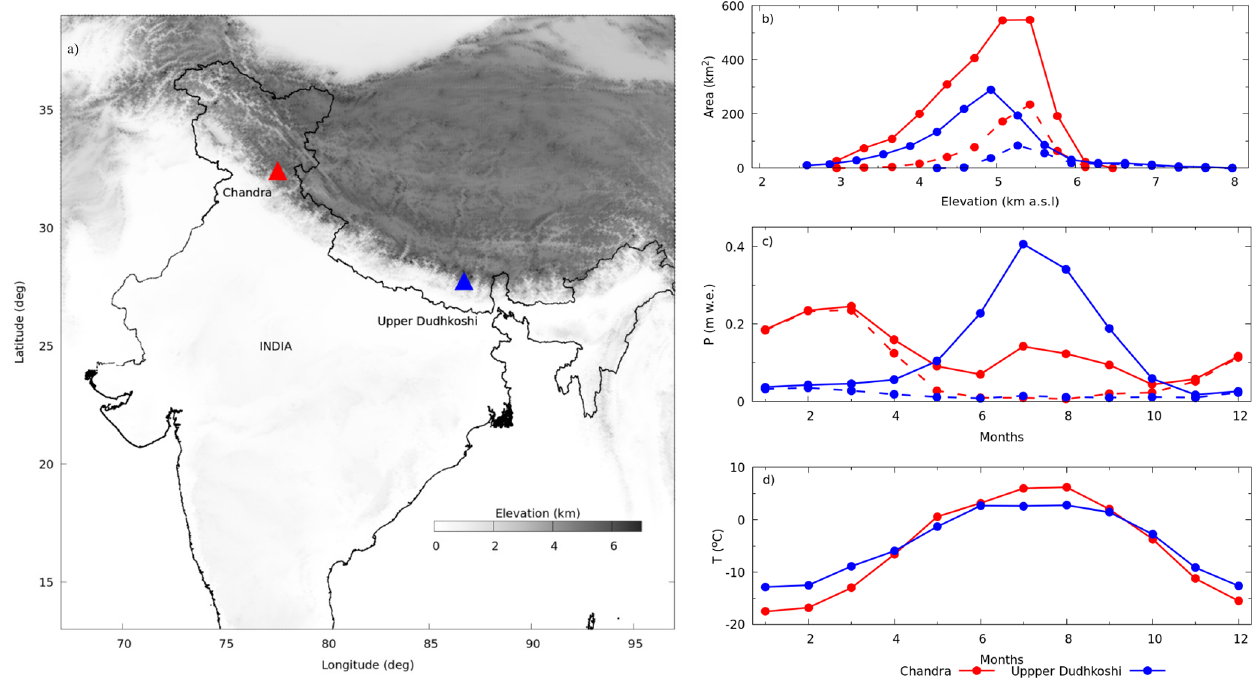
Figure 1. (a) The location of the Chandra (solid red triangle) and upper Dudhkoshi (solid blue triangle) catchments on a grey-scale elevation map (Amante and Eakins, 2009). In the rest of the plots, red (blue) colours refer to the Chandra (upper Dudhkoshi) catchment. The solid magenta (sky-blue) polygon shows Ganga (Indus) basin. (b) Area–elevation distribution of the catchments (solid lines + solid symbols) and that of the glacierised parts (dashed lines + solid symbols). (c) Mean monthly precipitation (solid lines + solid symbols), along with the monthly snowfall (dashed lines + solid symbols). (d) Mean monthly temperature profiles (solid lines + solid symbols).